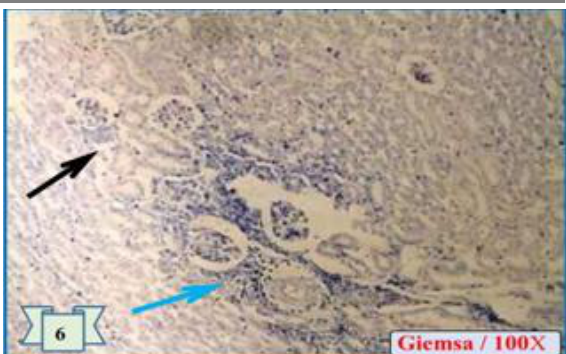
Figure, 2: Bacterial Kidney infection of common carp. Grossly show [1] present of diphtheric membrane which cover all internal organs (arrow), and [2] peritonitis and fibrinous enteritis (arrow), with [3] present of diphtheric membrane on anterior kidney (arrow), and [4] congestion of posterior kidney. Microscopically [5] there is sever hemorrhage (arrow) and congestion (arrow) in kidney tissue with coagulative necrosis (arrow), [6] microorganisms in kidney tissue (arrow) with infiltration of inflammatory cells (arrow).